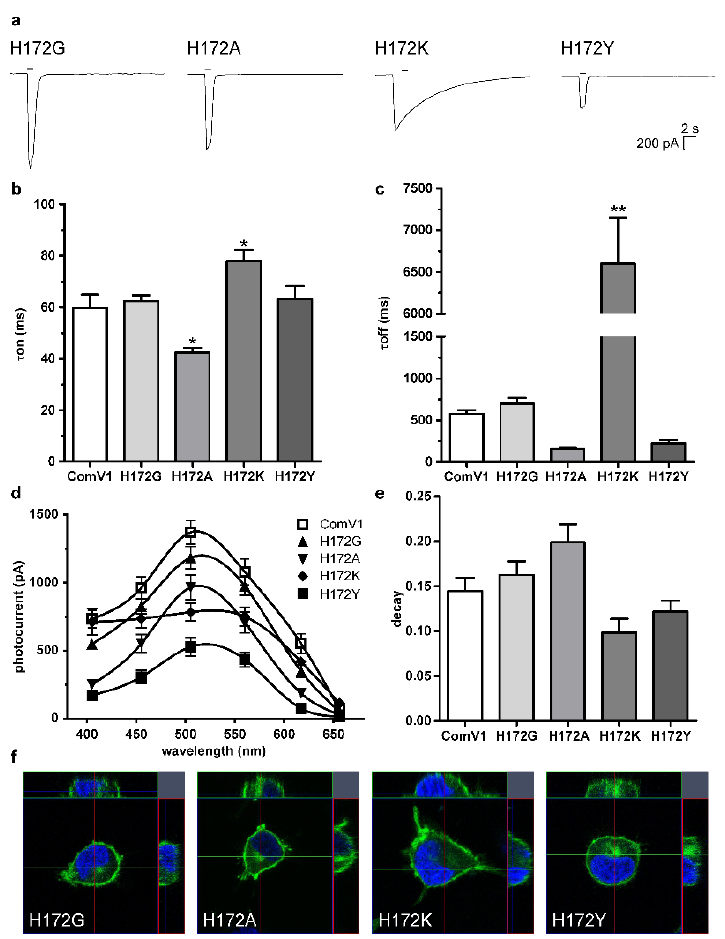
Figure 2. Electrophysiological profiles of ComV1 and the H172G, H172A, H172K, and H172Y mu- tants. ( a ) The typical waveforms evoked with 505-nm light adjusted to 1 µW/mm 2 for 1 s. ( b – e ) Comparison of τon ( b ), τoff ( c ), photocurrents ( d ), and decays ( e ) between ComV1 and its mutants. τon, τoff, and decays at 505 nm (Supplementary Material File Figure S1). Photocurrents were evoked with a light-emitting diode adjusted to 1 µW/mm 2 for 1 s. The data are shown as mean ± SEM (ComV1 n = 18–19, H172G n = 8, H172A n = 8, H172K n = 8, H172Y n = 8), and were analyzed using Dunnett’s multiple comparison test vs. ComV1 (* p < 0.05, ** p < 0.01). All data measured using light of various wavelengths and the results of statistical analysis are shown in Supplementary File Table S1 and Supplementary Files Table S2–S4, respectively. ( f ) The fluorescence of channelrhodopsin-Venus (green) and DAPI (blue) in each mutant.